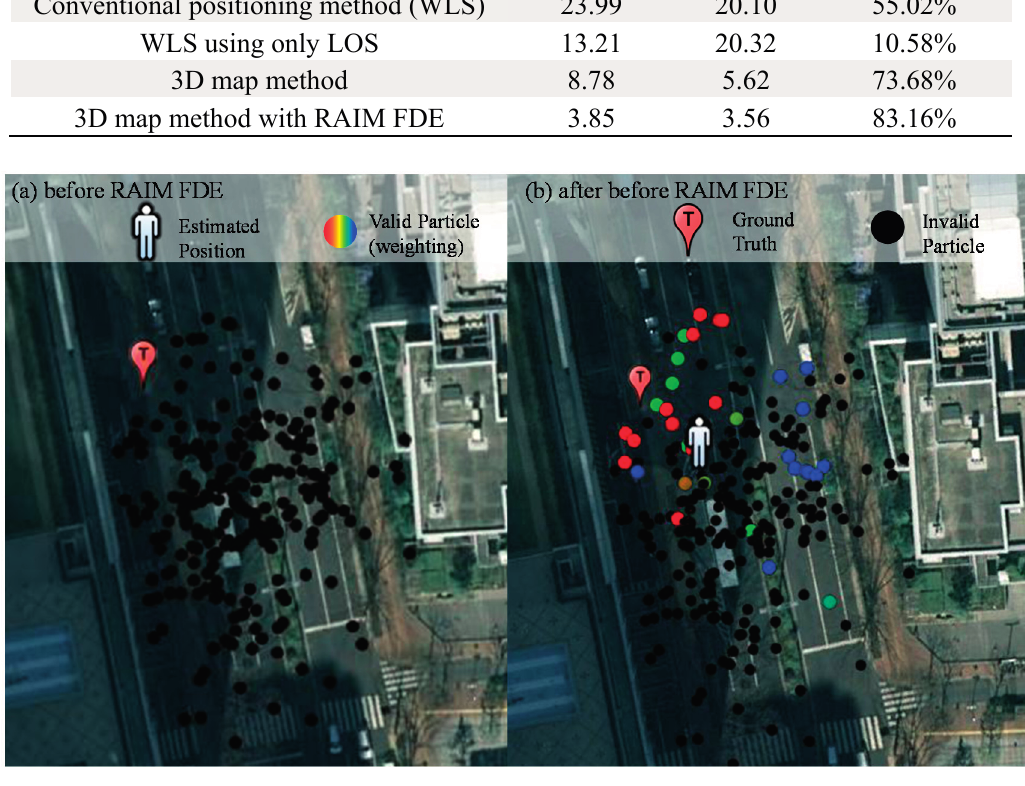
Figure 13. Weighting of all the particles of point 272,697 before ( a ) and after RAIM ( b